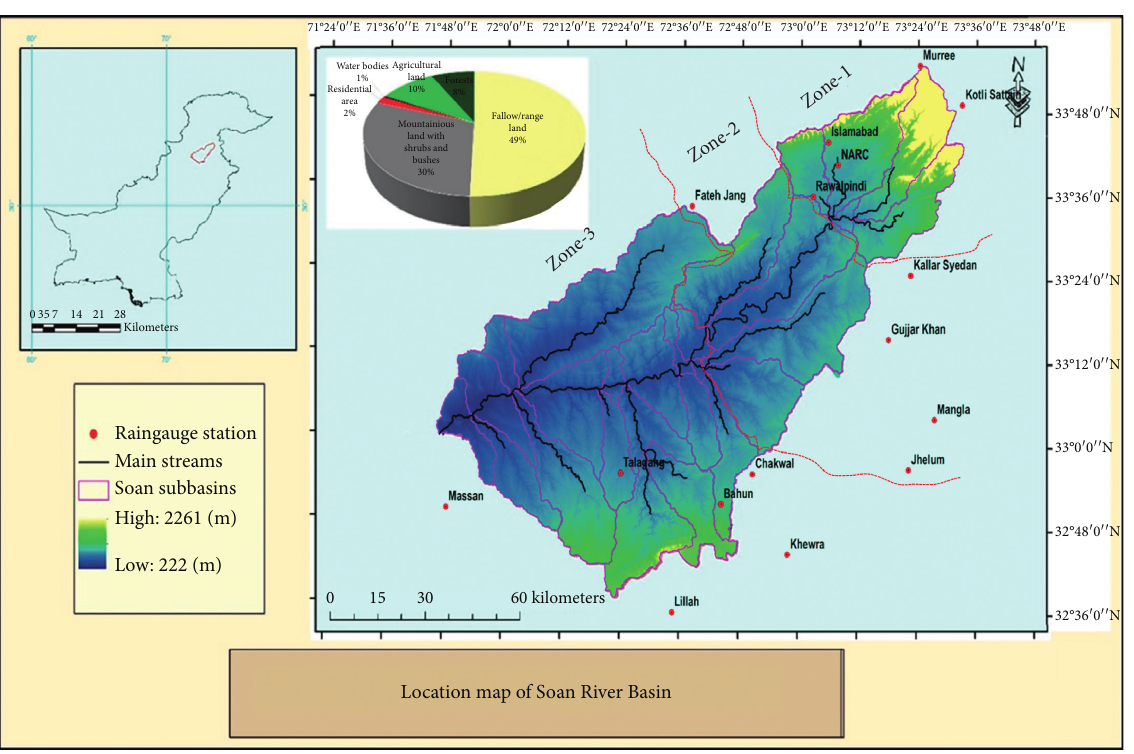
Figure 1: Location map of Soan River Basin, Pakistan: rain gauge stations, river and subbasins network, and